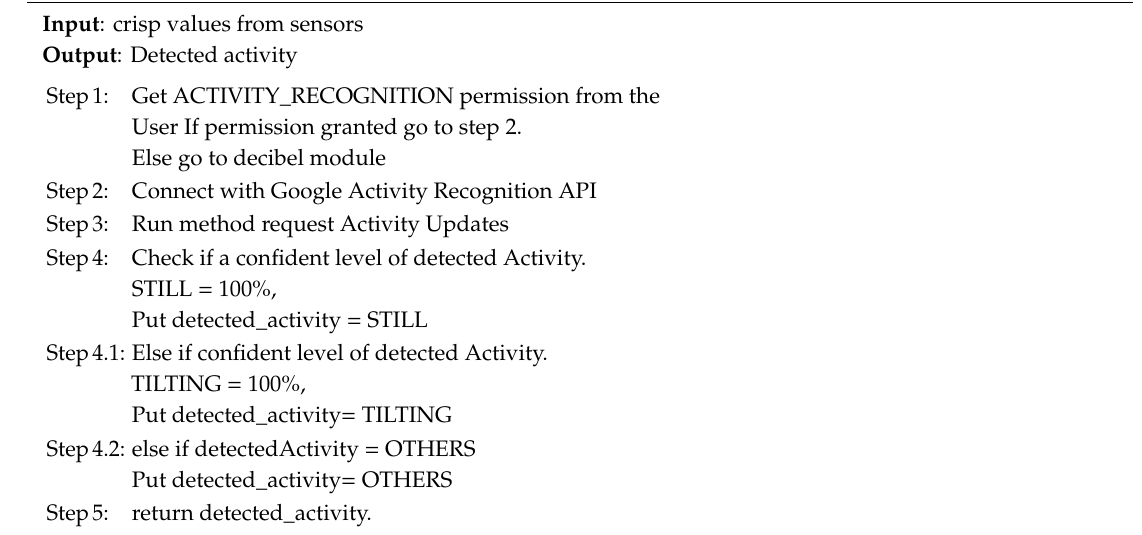
Algorithm 3: Activity-Recognition